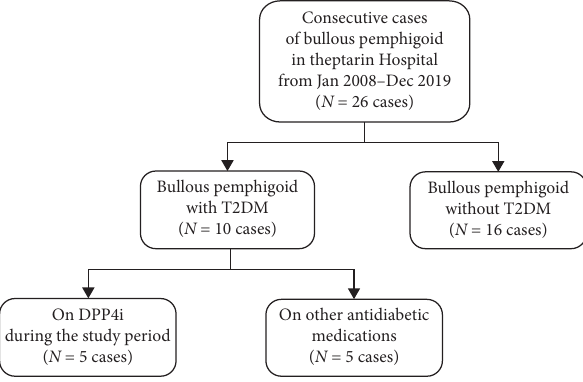
Figure 1: Flow selection of studied patients. Table 1: Summary of clinical characteristics and outcomes in our case series of DPP4i-associated bullous